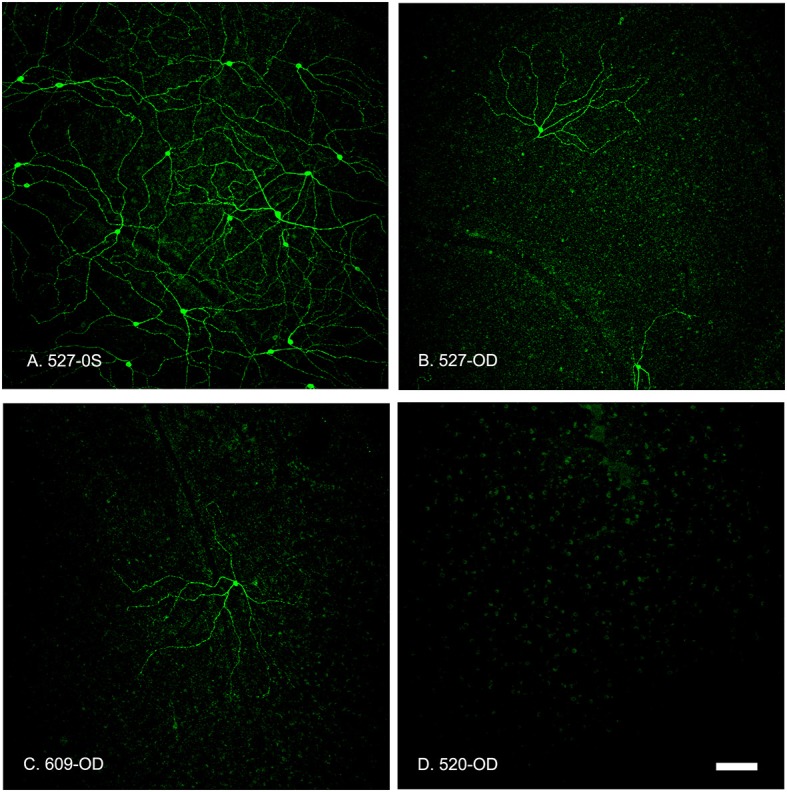
Summed z-stack projections of mid-peripheral retina taken at 10x magnification showed that the OPN4-IR cells provided coverage of the entire retinal section in control conditions (A, 527-OS). Retinas treated with increasing concentrations of OPN4-Saporin had few or no OPN4-IR cells. (B) 527-OD: 1 μg; (C) 609-OD: 0.316 μg; (D) 520-OD: 10 μg; Scale bar = 100 μm.